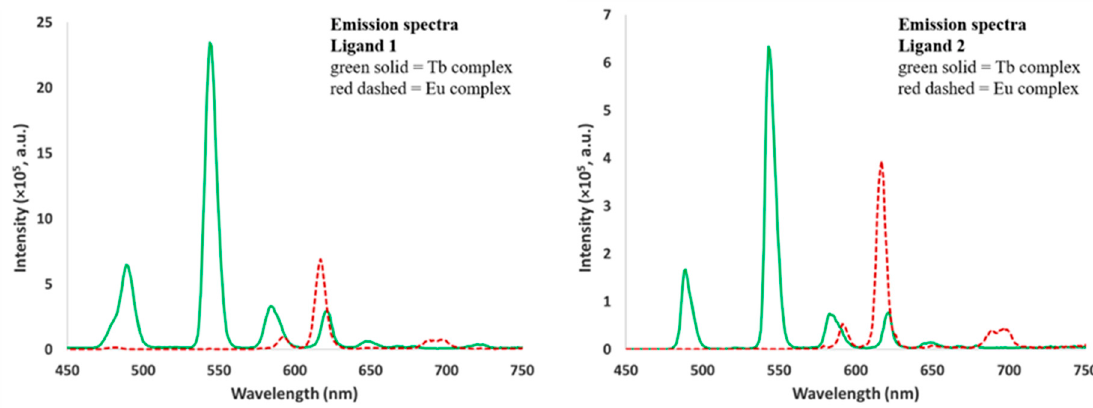
Figure 7. Emission spectra of the solutions of ligands 1 ( left ) and 2 ( right ), with one equivalent of Eu(NO 3 ) 3 and Tb(NO 3 ) 3 in acetonitrile. For ligand 1 : excitation wavelength 238 nm, excitation and emission slit widths = 5 nm, 2.2 mM ligand concentration; for ligand 2 : excitation wavelength 260 nm, excitation and emission slit widths = 2 nm, 1.0 mM ligand concentration. Note: for the acquisition of